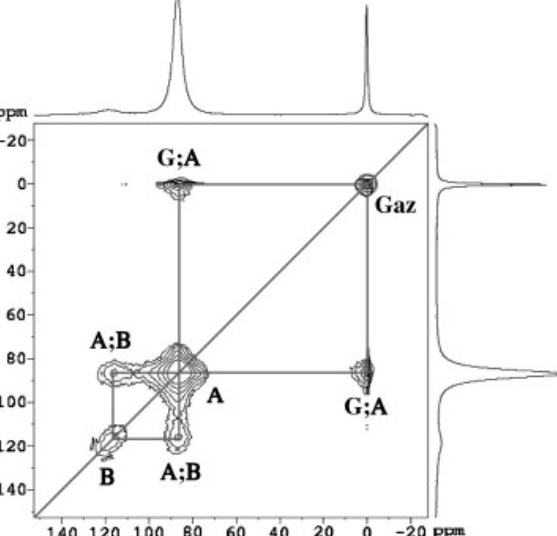
Figure 11. Hyperpolarized 129 Xe 2D exchange spectroscopy (EXSY) spectrum of CMK ‐ 3 acquired at 293 K and a mixing time of 50 ms. Reprinted with permission from reference [114]. Copyright 2009 Carbon.